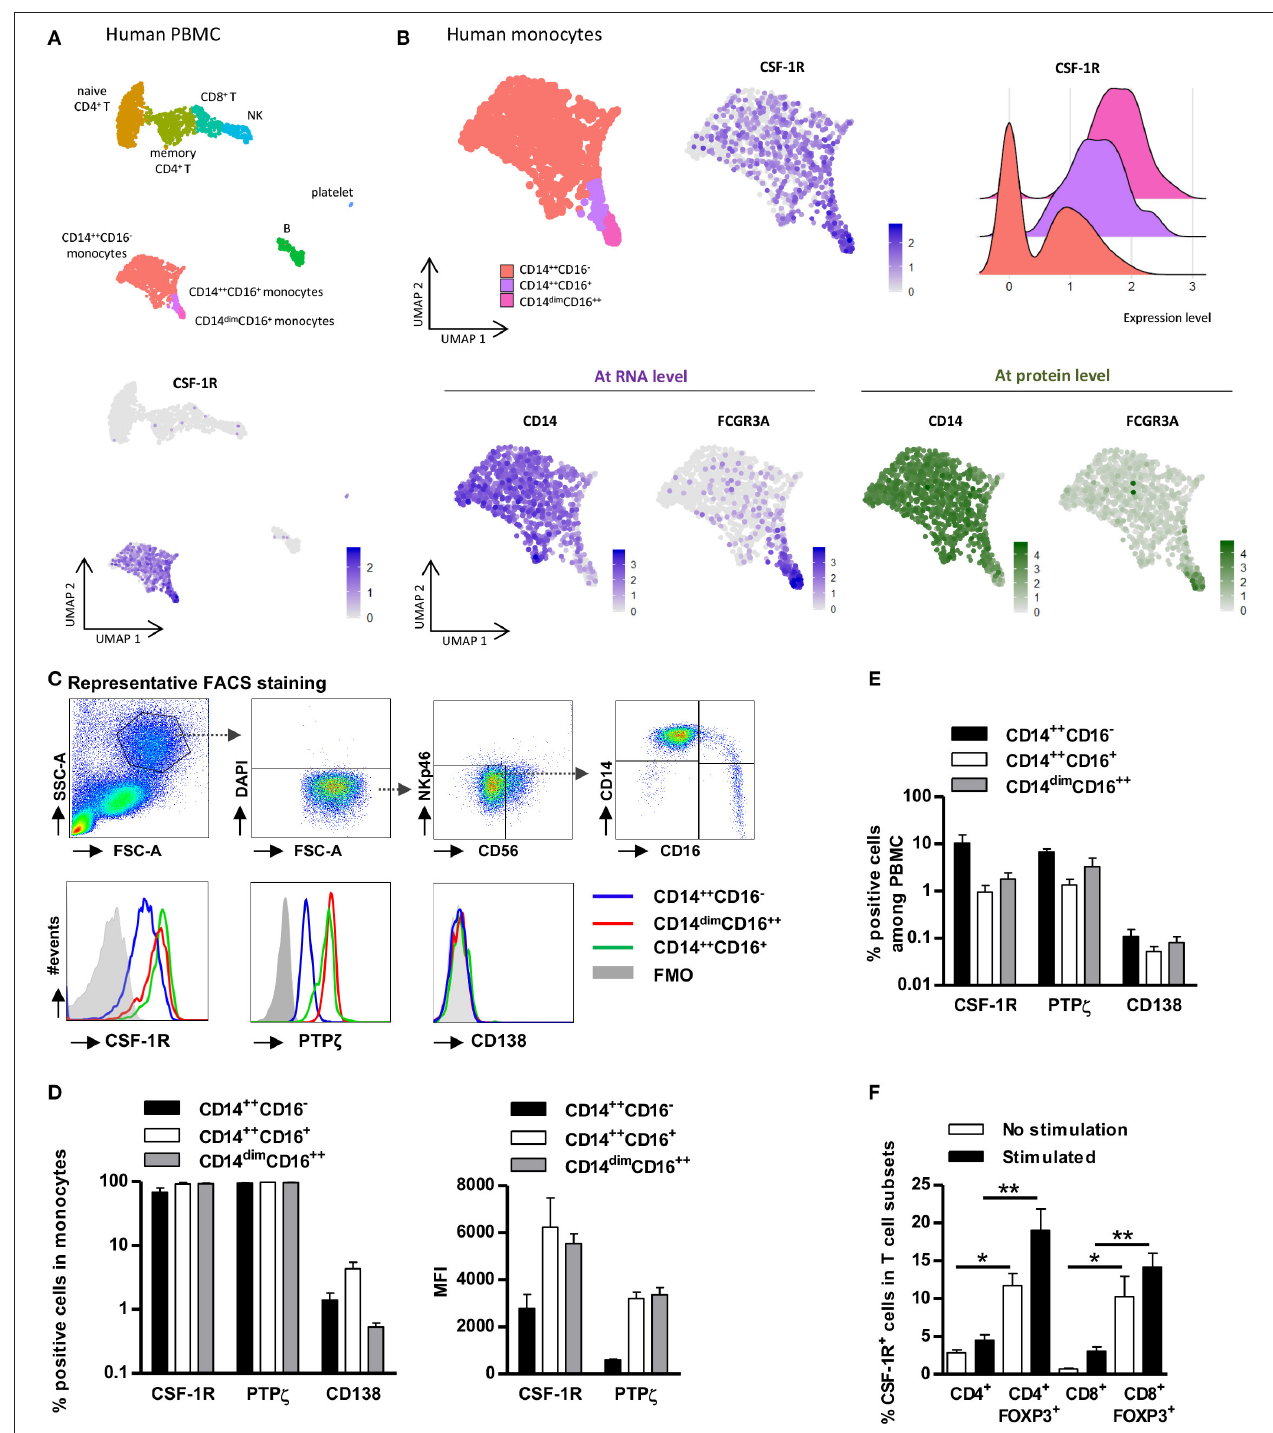
FIGURE 1 | CSF-1R and PTP ζ expression is restricted to monocytes and FOXP3 + Tregs. PBMCs were analyzed for CSF-1R expression at single cell transcriptional (A,B) and proteomic levels (C–F) . (A) Top: UMAP visualization of a public dataset of resting Human PBMC single cell RNA-seq from one healthy volunteer for which subsets of monocytes, T cells, B cells, and NK cells were identified by antibody staining. Bottom: CSF-1R expression in total PBMCs. One point represents one cell. Relative expression level is scaled from gray to dark blue. (B) Monocyte subsets were further subdivided based on RNA (RNAseq, bottom left) and protein expressions (CITEseq, bottom right) of CD14 (left) and FCGR3A (CD16) (right) summarized in the UMAP visualization (upper left), and subsets were analyzed for CSF-1R RNA expression (upper middle and right). One point represents one cell. Relative expression level is scaled from gray to dark blue (RNA expression) or from gray to dark